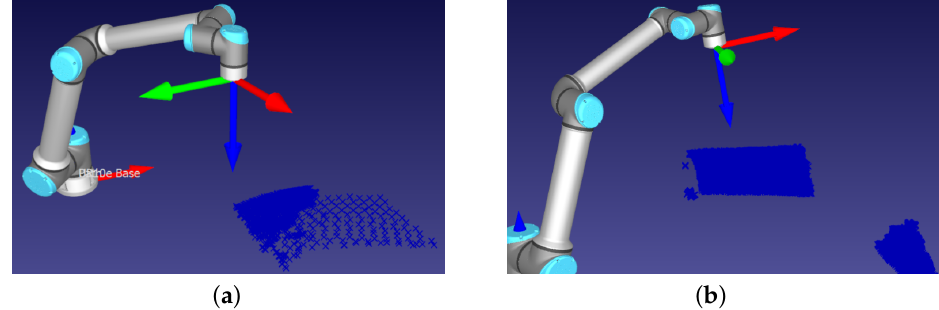
Figure 5. Scanning of a mock-aerofoil sample. The original RGB/D data poorly represented the surface, with an offset of 5 mm. Imaged within RoboDK. ( a ) Path , and in high-frequency segments the laser-discovered positions on the part. ( b ) Original Point cloud of the part and environment.